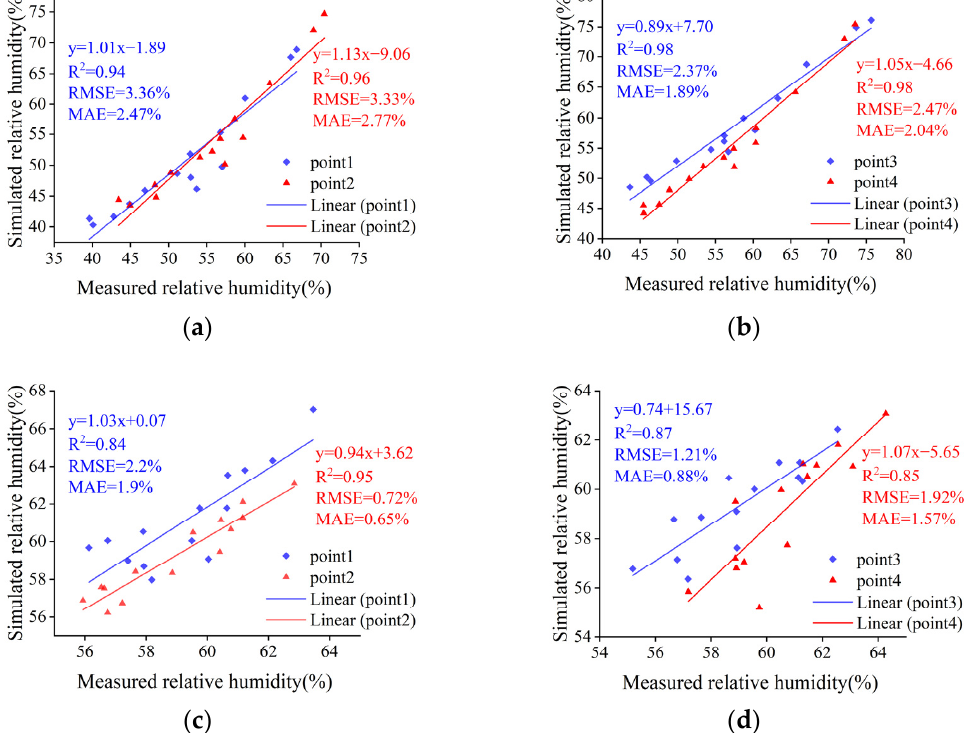
Figure 8. Relationship between the simulation and measurement for relative humidity. ( a ) Points 1 and 2 in summer, ( b ) points 3 and 4 in summer, ( c ) points 1 and 2 in winter, and ( d ) points 3 and 4 in winter.